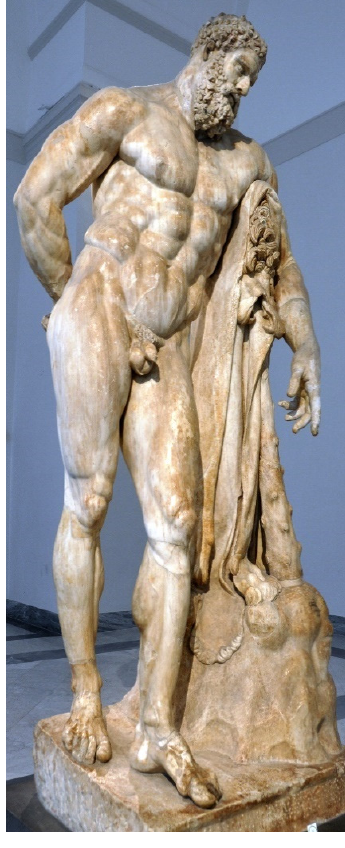
Figure 15. Farnese Hercules . National Archaeological Museum, Naples.